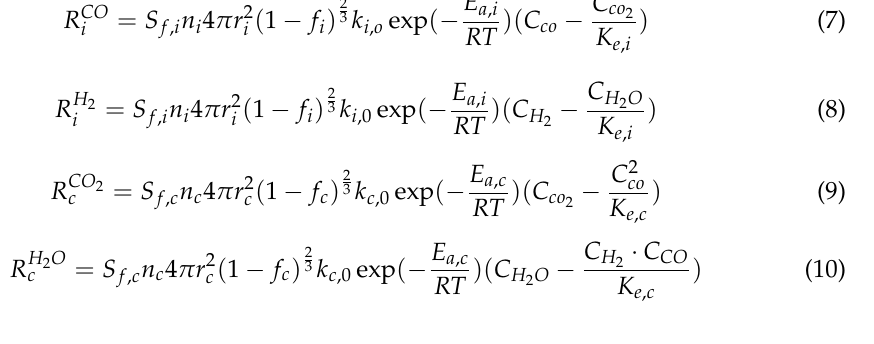
Table 3. Kinetic parameters of heterogeneous reactions [24].